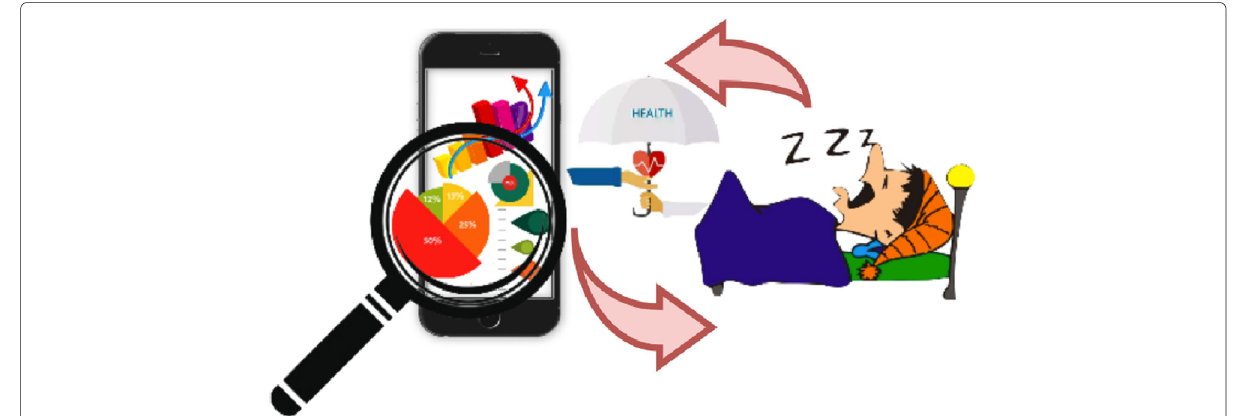
Fig. 1 The interactions between real-time data and people’s mentality and well-being